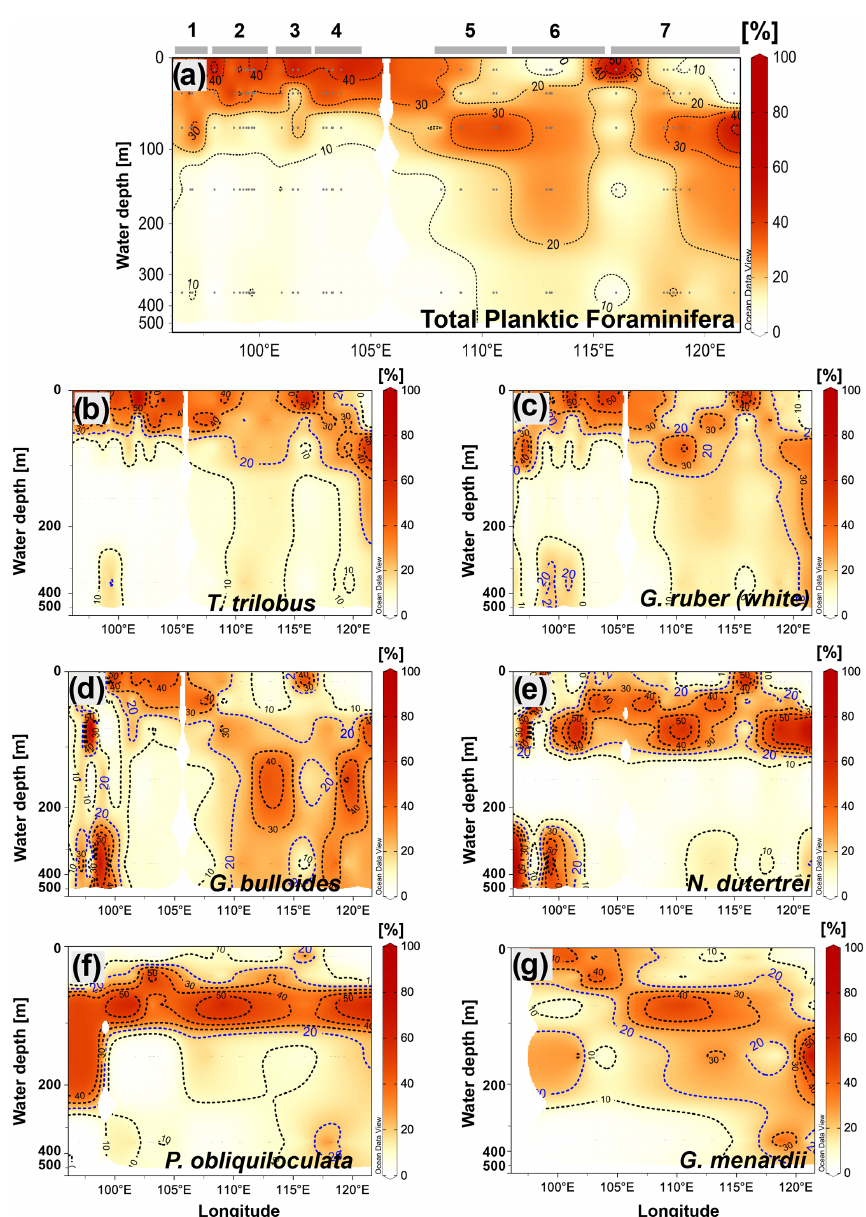
Figure 5. Cross-sections showing the vertical distribution across the water column of (a) the total community of planktic foraminifera and the species, (b) T. trilobus , (c) G. ruber (white), (d) G. bulloides , (e) N. dutertrei , (f) P. obliquiloculata , and (g) G. menardii . Numbers and horizontal lines on top of (a) show each transect (1 to 7). Visualization is based on Ocean Data View 5.2.1 (Schlitzer, 2021).